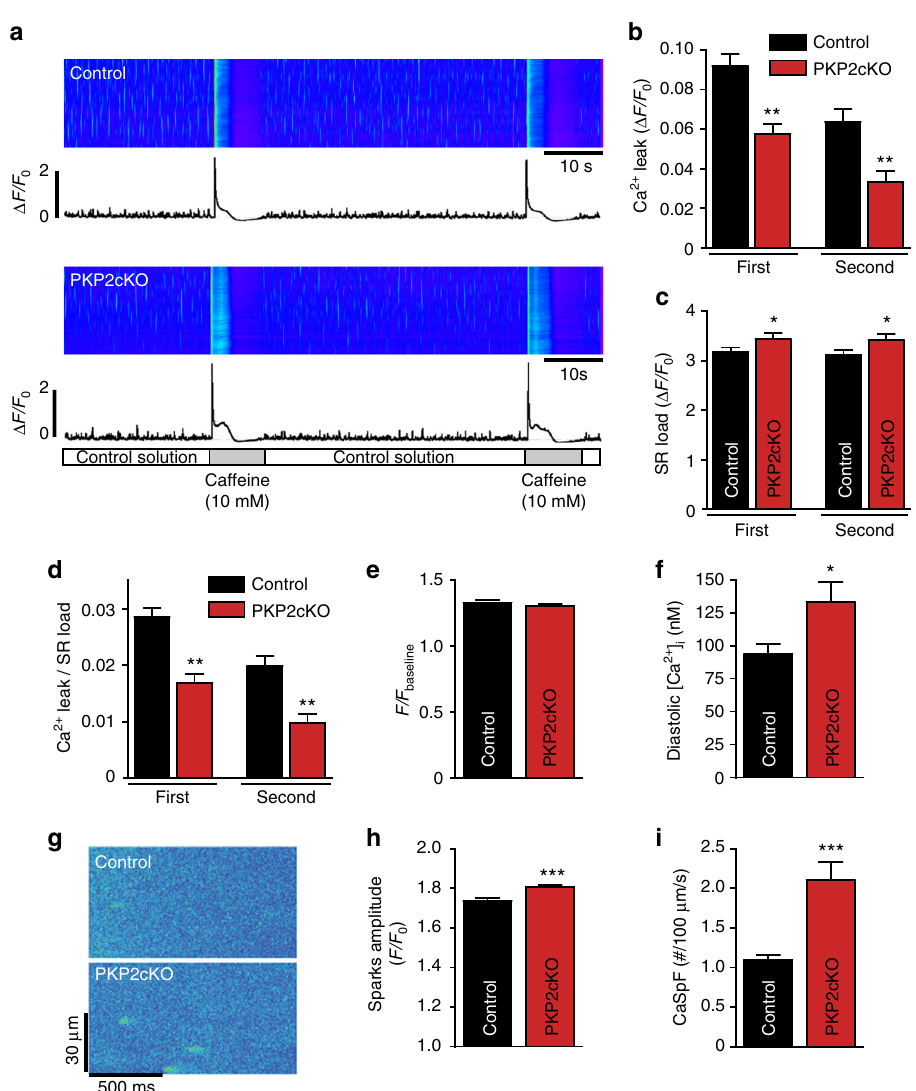
Fig. 7 Dysruption of [Ca 2+ ] i homeostasis in PKP2-cKO cardiomyocytes at 21 dpi. a Laser scanning confocal image of Ca 2+ in control ( top ) and PKP2-cKO ( bottom ) permeabilized cardiomyocytes. b Sarcoplasmic reticulum (SR) Ca 2+ leak in control ( n = 30 cells from three hearts, black ) and PKP2-cKO cardiomyocytes ( n = 23 cells from three hearts, red ). Statistical difference was estimated by measuring the average of spontaneous Ca 2+ release without any stimulation. ** p < 0.01 vs. control. c SR Ca 2+ load estimated by measuring the peak of caffeine-induced Ca 2+ release from control ( n = 30 cells from three hearts, black ) and PKP2-cKO permeabilized cardiomyocytes ( n = 23 cells from three hearts, red ) relative to the fl uorescence intensity at baseline ( F 0 ). Given that cells were permeabilized, F 0 was the same for control and for PKP2-cKO. * p < 0.05 vs. control. d Ratio between Ca 2+ leak and SR Ca 2+ load in permeabilized cells, ** p < 0.01 vs. control. e Peak of caffeine-induced Ca 2+ release ( F ) in control ( n = 33 cells from three hearts, black ) and PKP2-cKO intact cardiomyocytes ( n = 34 cells from three hearts, red ) relative to fl uorescence at baseline ( F baseline ). f Diastolic [Ca 2+ ] i in control ( n = 10 cells from three hearts) and PKP2-cKO ( n = 10 cells from three hearts) cardiomyocytes. Student ’ s t -test * p < 0.05. This result indicates that F at baseline ( F baseline ) for the data in e was not the same for the two groups. The combined data in e and f indicate an increase in SR load in intact cells. g Representative confocal line- scan images of Ca 2+ sparks recorded in control and PKP2-cKO cardiomyocytes. h , i Bar graphs depicting Ca 2+ spark amplitude ( F / F 0 ) and Ca 2+ spark frequency, respectively, measured as the number of events per unit time and length in control ( n = 200 sparks, N = 27 cells from three hearts, black ) and PKP2-cKO intact cardiomyocytes ( n = 457 sparks, N = 30 cells from four hearts, red ). Student ’ s t -test, *** p < 0.001 vs.